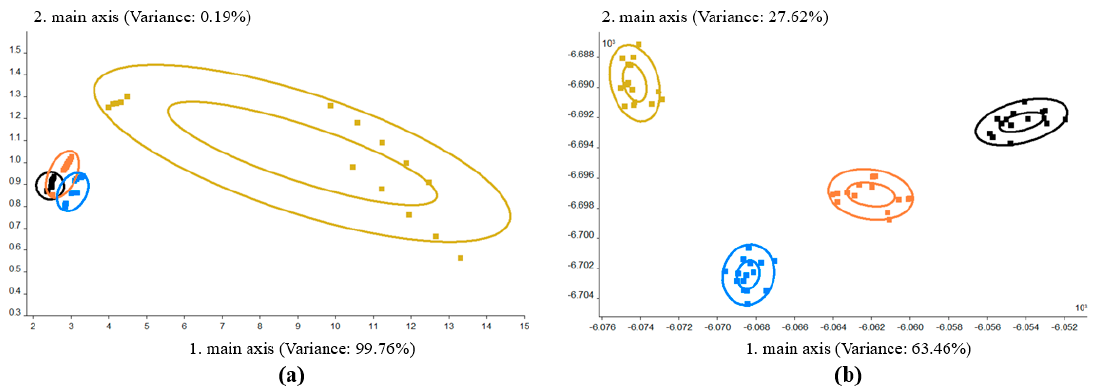
Figure 1. Results obtained by using the electronic nose. ( a ) Principal component analysis (PCA) and ( b ) linear discriminant analysis (LDA) of the electronic nose data for the control (CK; black), triadimefon-treated (SZT; orange), tebuconazole-treated (WZC; blue), and paclobutrazol-treated (DXZ; yellow) wine groups.